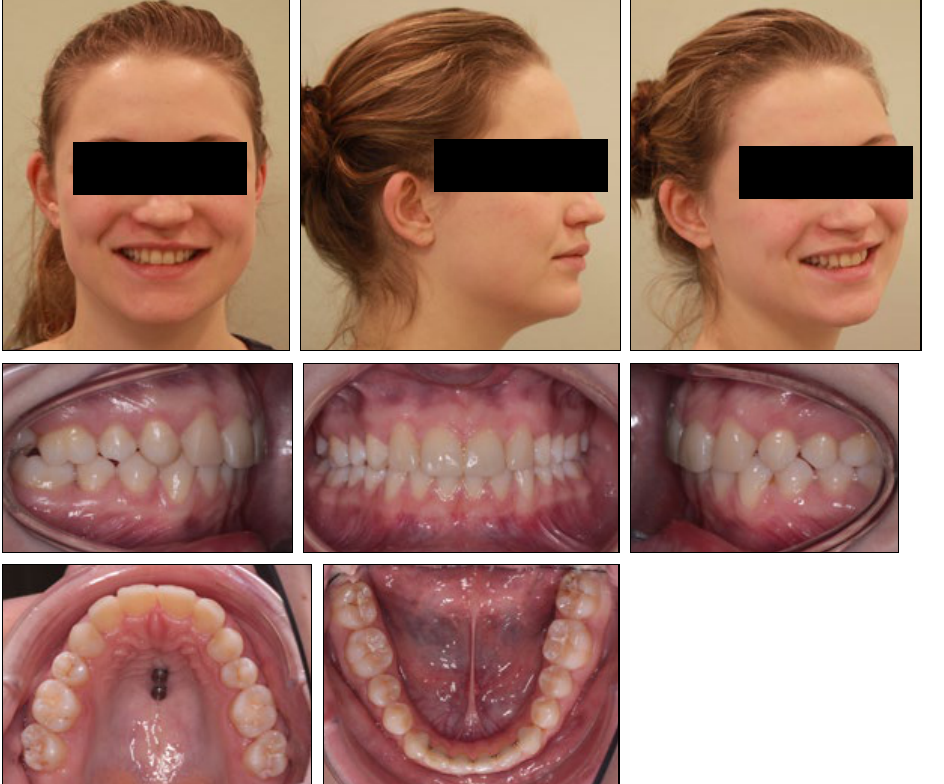
Figure 17. Facial and intraoral photographs after one year of